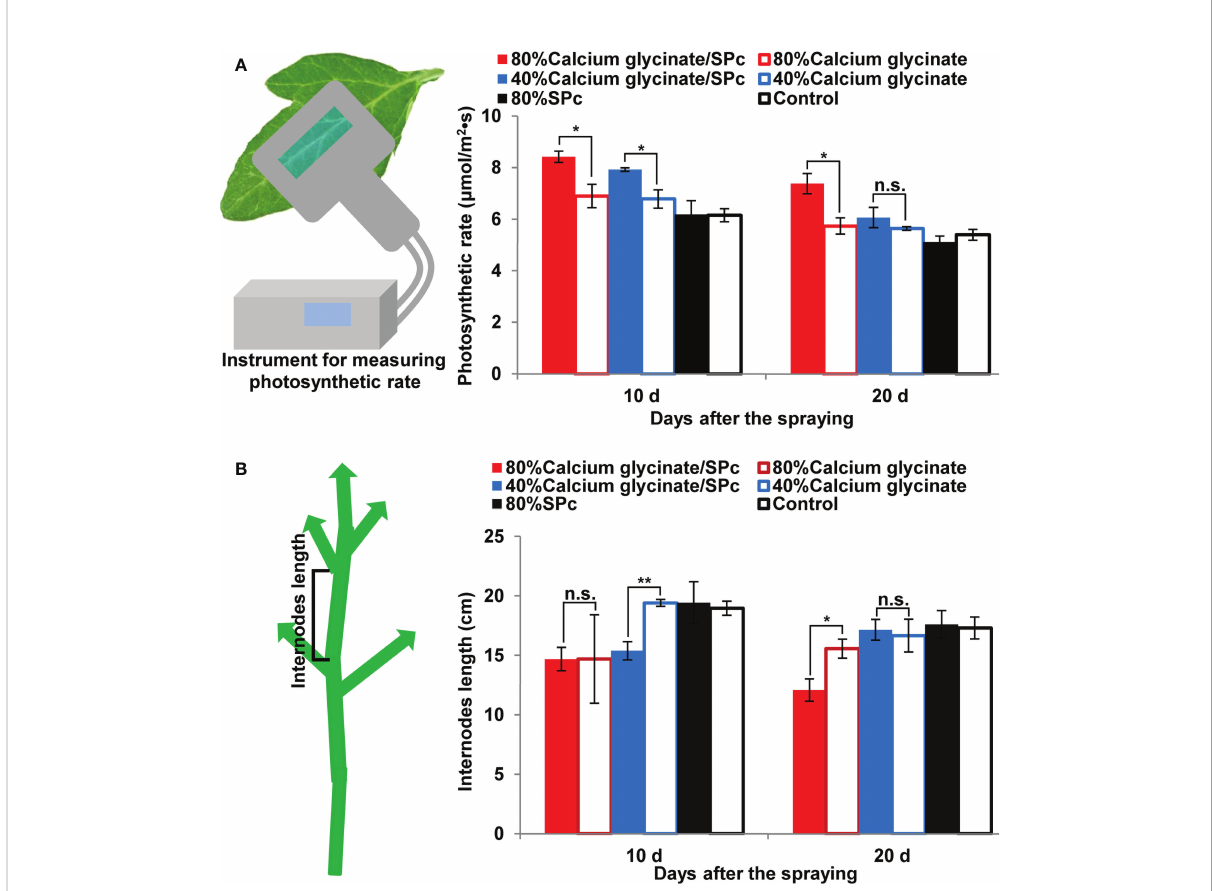
FIGURE 6 Effects of SPc-loaded calcium glycinate on the photosynthetic rate (A) and internodes length (B) of tomato leaves/seedlings. The seedlings were sprayed with various formulations at 80% and 40% recommended fi eld concentration. The photosynthetic rate and internodes length were measured at 9:00-10:00 a.m. at 10 d post the fi rst and second applications. Five leaves/seedlings were tested in each plot. The “ * ” and “ ** ” indicate signi fi cant differences (Independent t test, P < 0.05 and P < 0.01), and “ n.s. ” indicates no signi fi cant